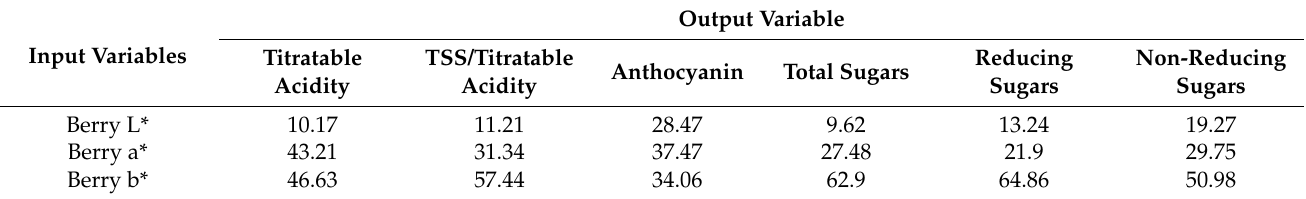
Table 7. Relative importance (%) of the input variables for ANN model predictions of